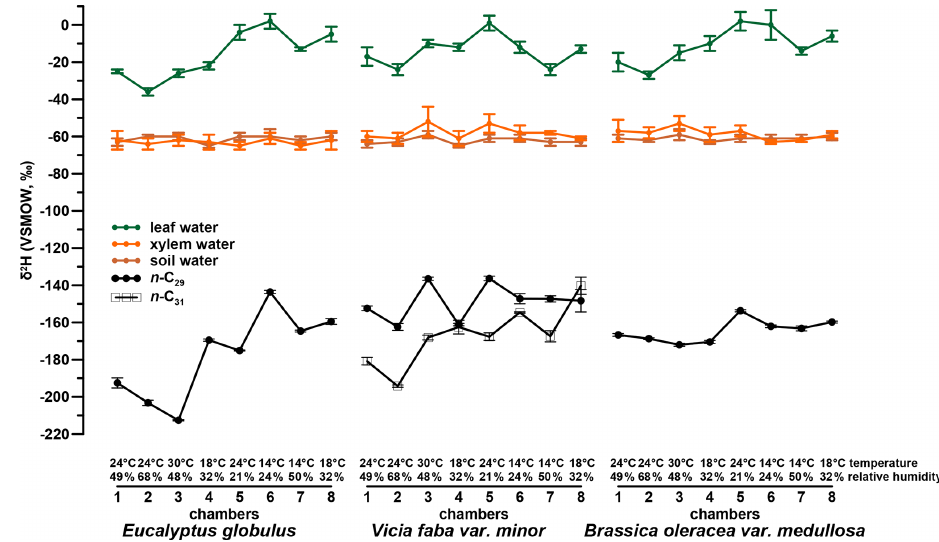
Figure 2. δ 2 H values of plant water (leaf water, xylem water and soil water) isotope compositions (in green, orange and brown, respectively) and the isotope composition of the investigated leaf wax n -alkanes n -C 29 and n -C 31 as dots and open squares, respectively.